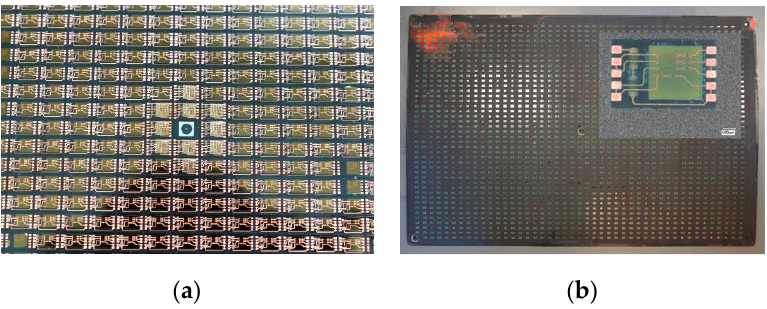
Figure 7. Processed fan-out panel; ( a ) panel detail, ( b ) panel overview with package detail (ASIC with SMD